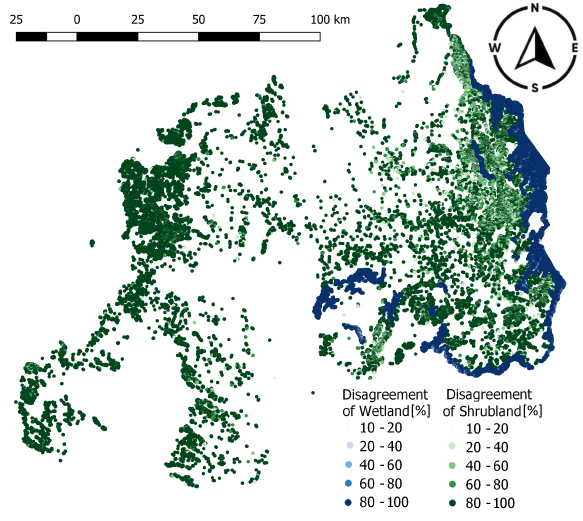
Figure 3. Map of disagreement between Shrubland (green) and Wetland (blue) classes of GL30 with different classes of CCI Africa